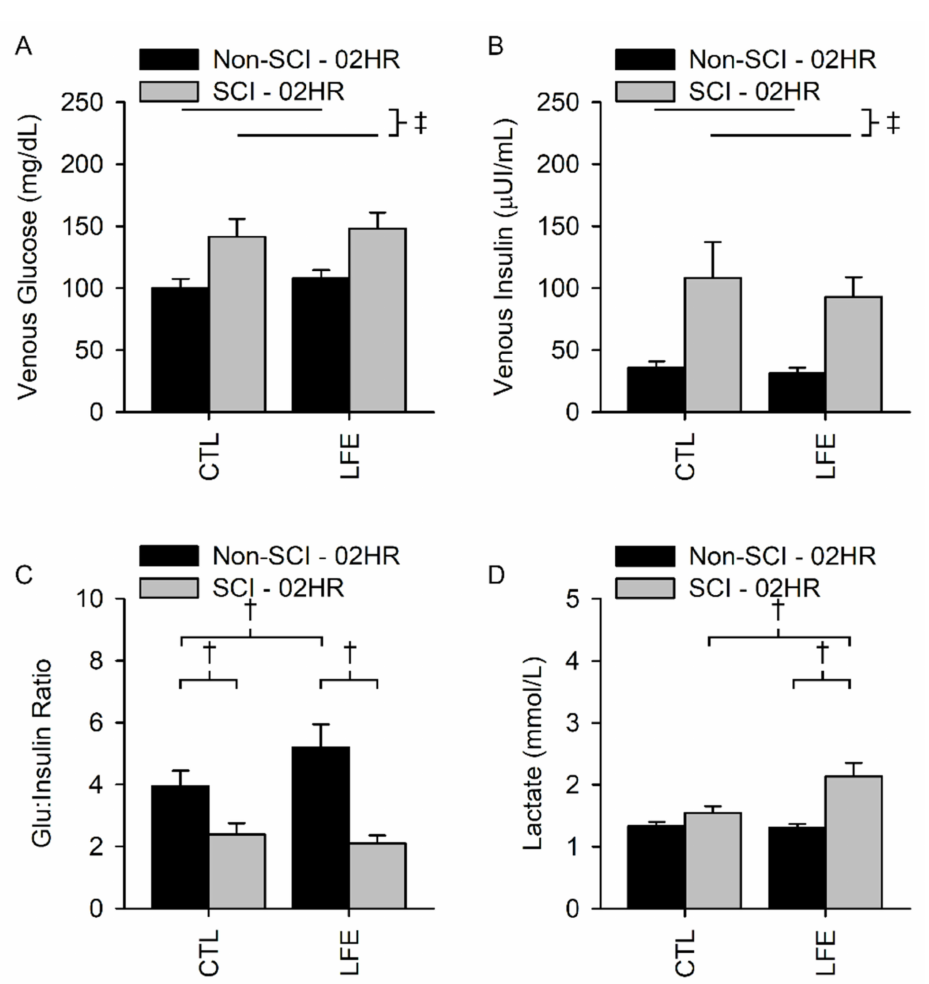
Figure 4. 2-h Venous blood biomarkers. There was no interaction for glucose ( A ) and insulin ( B ). However, people with SCI had a higher glucose and insulin response than the non-SCI participants. There was a significant interaction for the glucose to insulin ratio ( C ) and lactate ( D ). People with SCI had a lower glucose to insulin ratio after LFE and during the CTL session compared to the non-SCI participants. Interestingly, there was also an increase in the glucose to insulin ratio for the non-SCI participants after LFE compared to their CTL session. Lactate was significantly higher in people with SCI after LFE compared to their control session and compared to the non-SCI cohort after LFE. † Indicates a significant difference ( p ≤ 0.05) of the indicated simple effect during post hoc testing due to a significant interaction between population and session. ‡ Indicates a significant difference ( p ≤ 0.05) of the indicated main effect and no significant interaction between session and population. 3.5. Capillary Glucose (cAUC) and Heart Rate during Control and LFE OGTT Capillary glucose area under the curve(cAUC) for the control sessions in the SCI and non-SCI populations were 303.2 ± 67.3 and 266.4 ± 40.2 mg h/dL, respectively. Fasting capillary glucose levels (cAUC) for the LFE sessions in SCI and non-SCI populations were 289.5 ± 68.0 and 255.6 ± 37.6 mg/dL, respectively. There was no interaction between popu- lation and exercise session ( p = 0.837). There was a difference in cAUC between the control and LFE session but it did not reach a level of significance ( p = 0.08). However, people with SCI had a significantly higher cAUC compared to people without SCI ( p = 0.0.027) (Figure